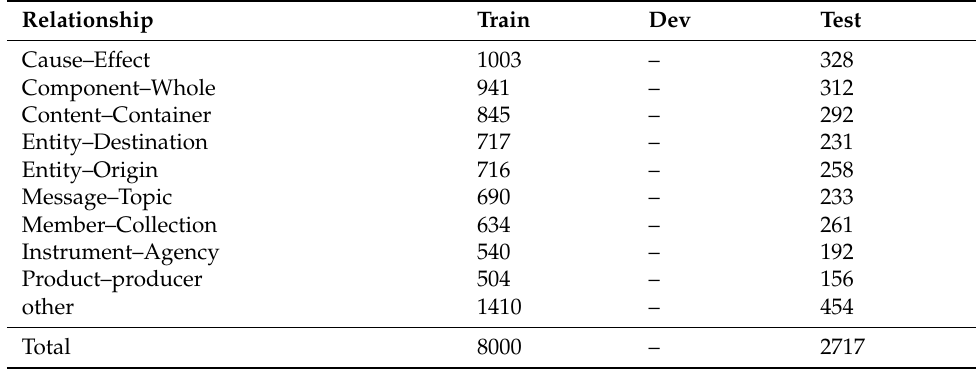
Table 3. Data distribution of the SemEval-2010 Task8 dataset.